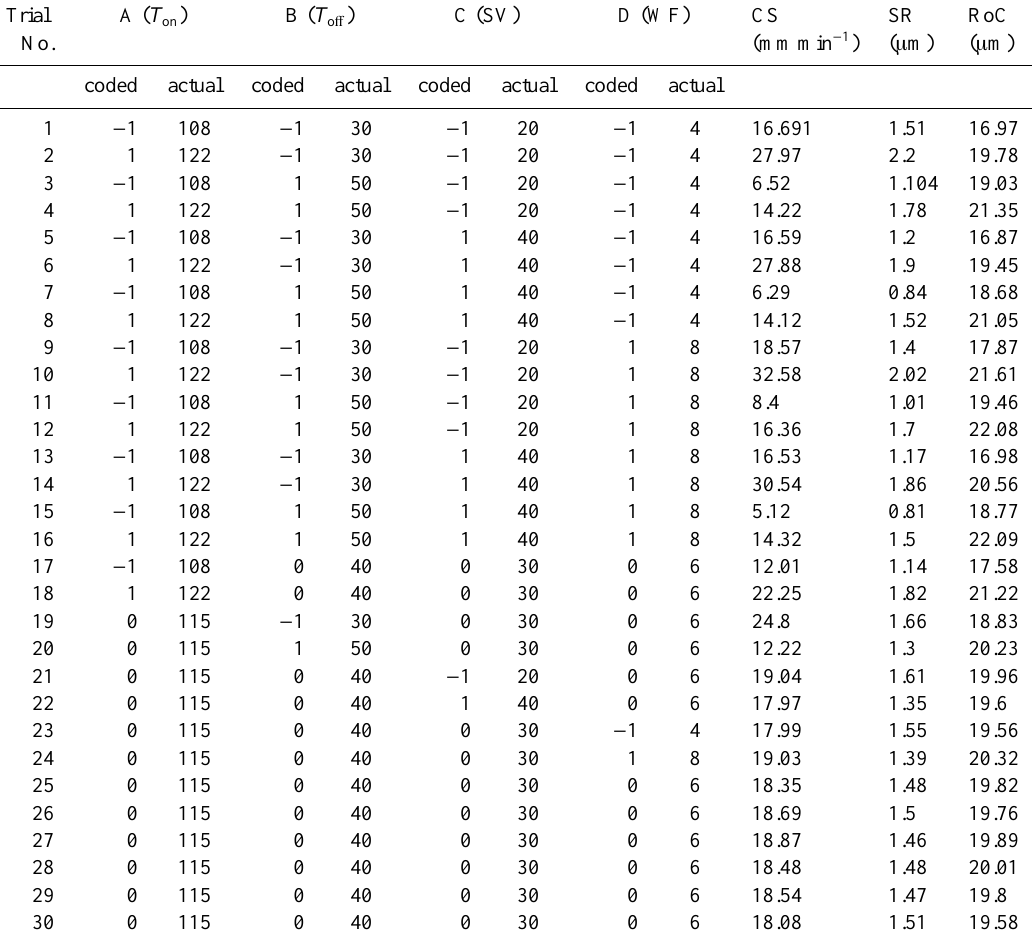
Table 2. Test conditions in face-centered central composite